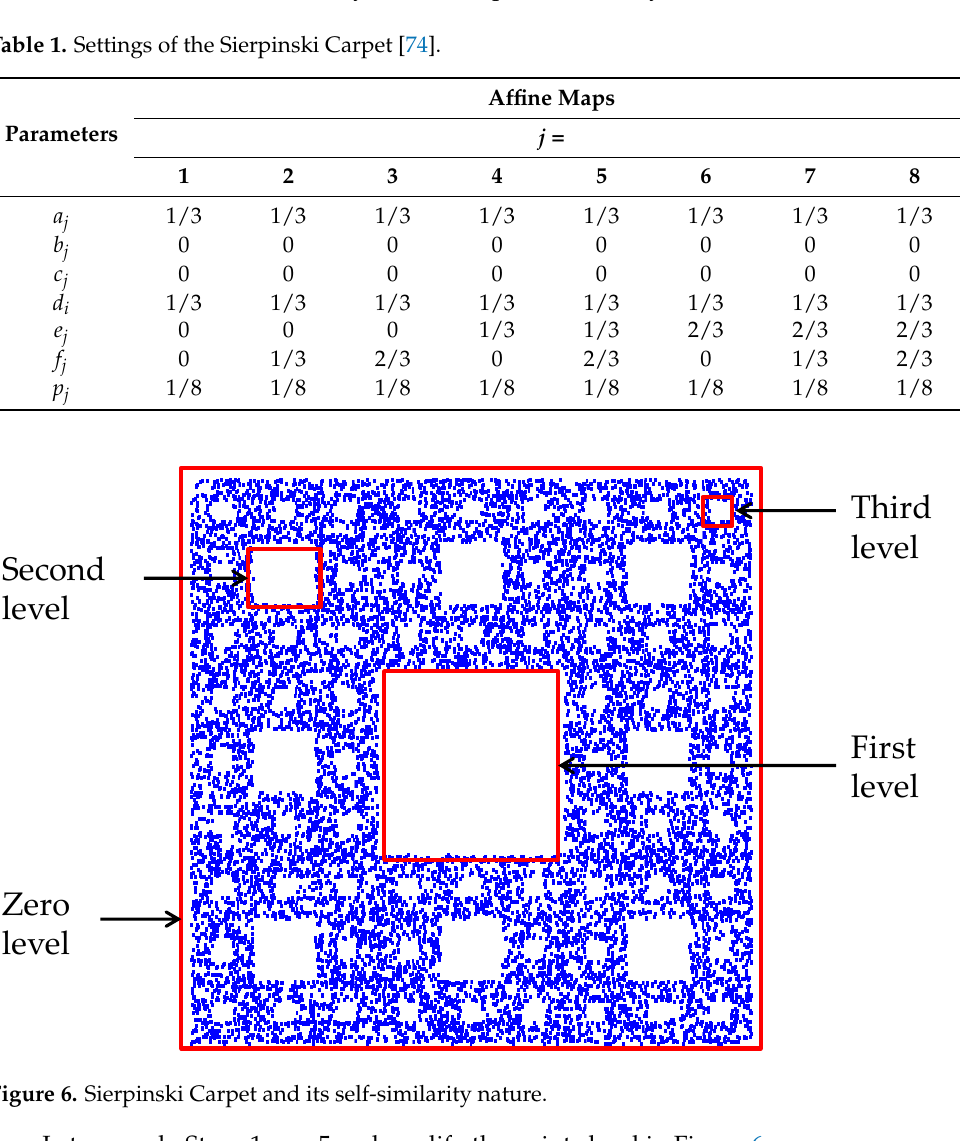
Table 1. Settings of the Sierpinski Carpet [74].